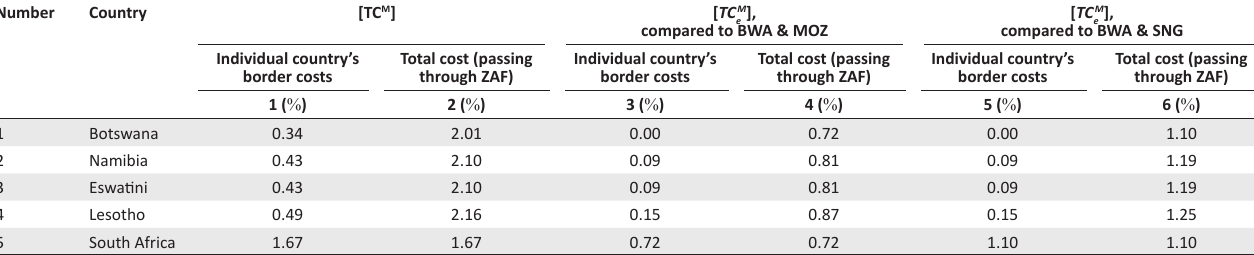
TABLE 3: Estimates of the actual rate of cost to import and estimated rate of excess cost to import. * Number Country [TC M ]